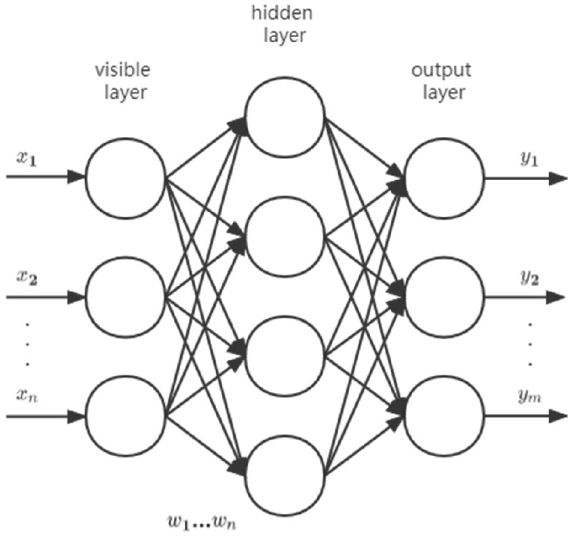
Figure 4. Three layers network structure.